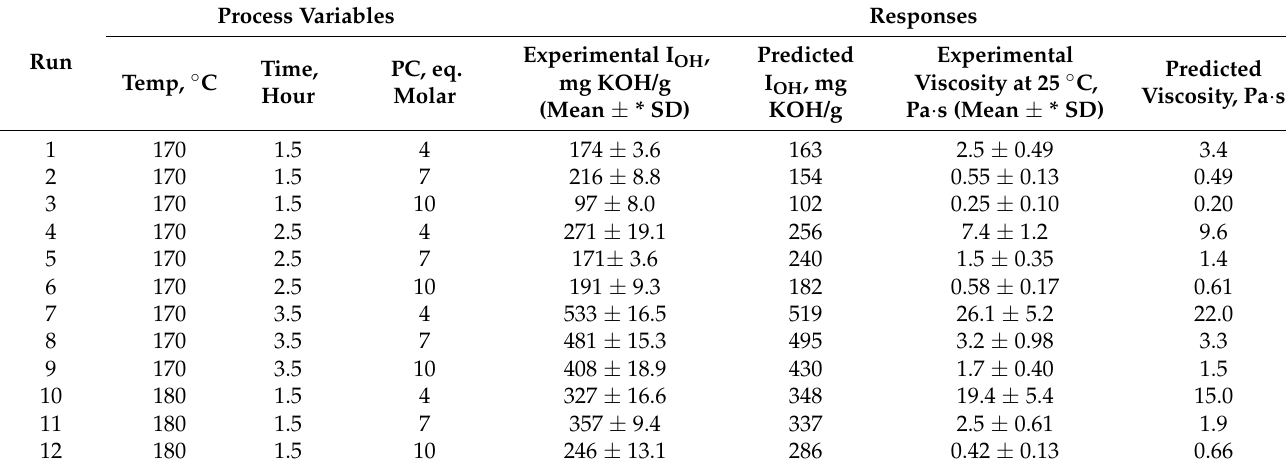
Table 2. Design matrix and the results of experiments.